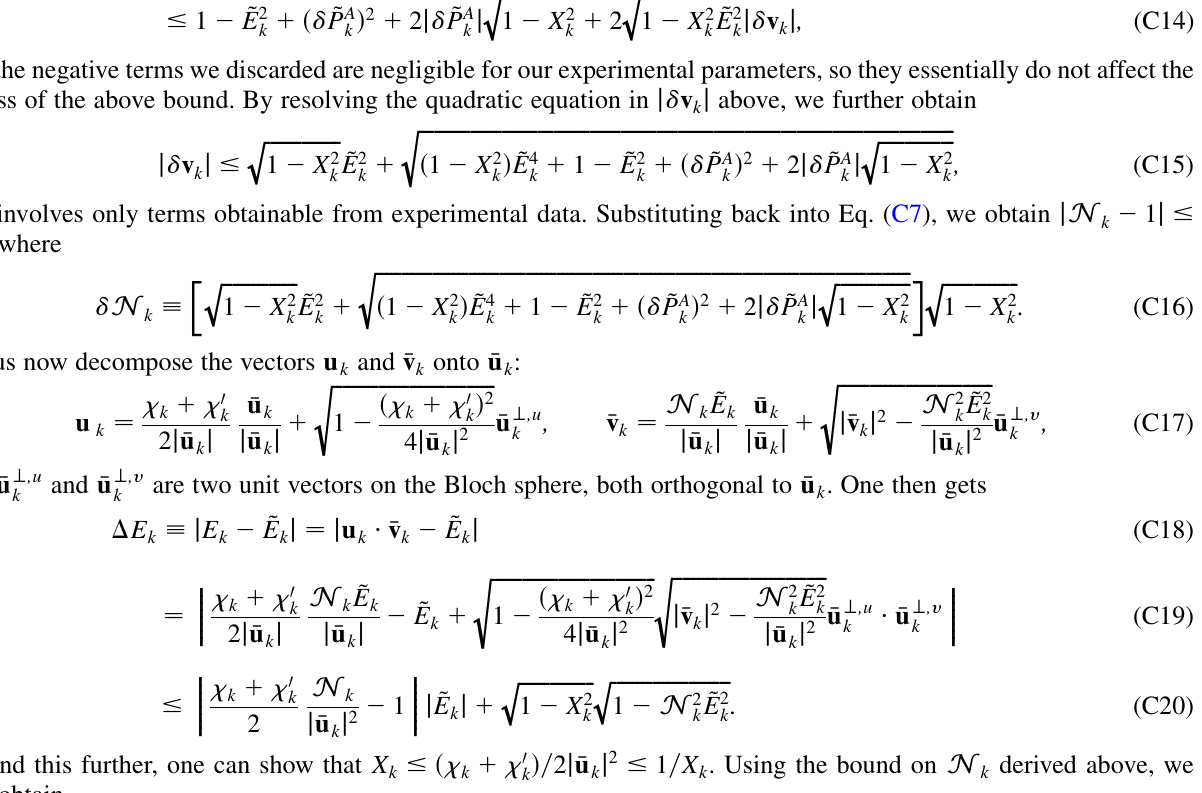
ffiffiffiffiffiffiffiffiffiffiffiffiffiffiffi p 1 (cid:2) X